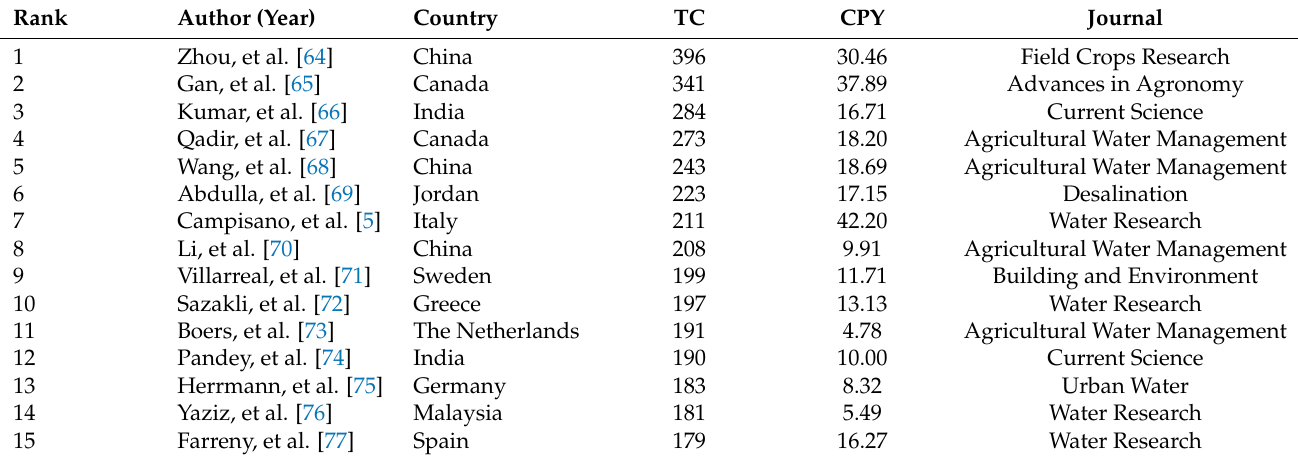
Table 4. The most frequently cited articles on RWH related studies.